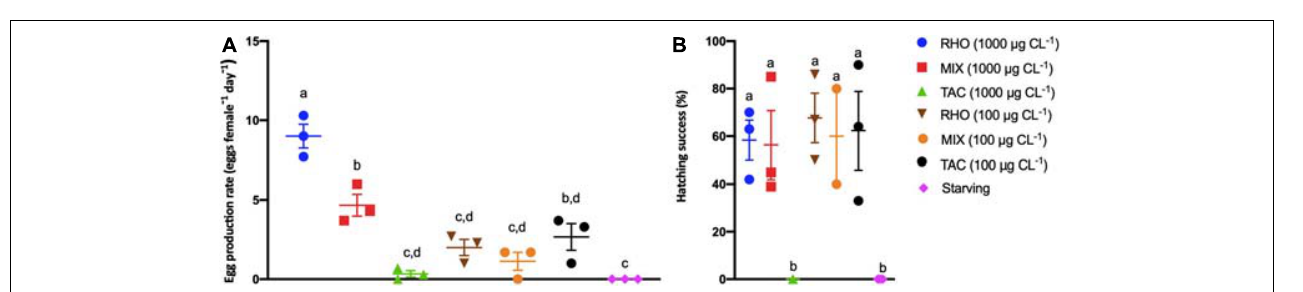
FIGURE 2 | Egg production and hatching success of Acartia tonsa fed on RHO ( Rhodomonas sp.; blue circles), TAC (toxic Alexandrium catenella 1119/27; green triangles), and NAC (non-toxic A. catenella 1119/19; red squares) at a concentration of 1,000 µ g C L − 1 or when starved (purple diamond). Dots are replicates and bars show the mean ± standard error (SE). (A) Eggs produced (24–48 h) after acclimation period. (B) Nauplii hatched (48–96 h). The a and b letters above bars show the post hoc comparisons between the treatments with shared letters denoting no significant difference.